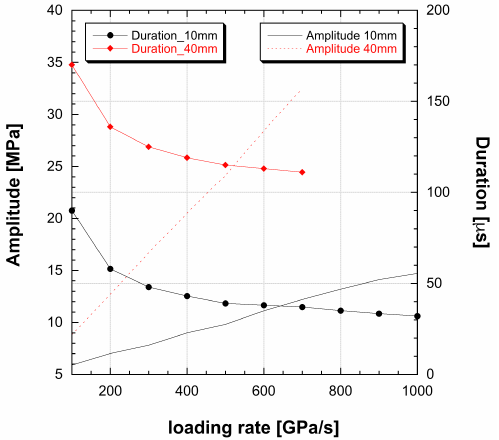
Figure 8. Dynamic strength and amplitude obtained by DAMP model on D10 and D40